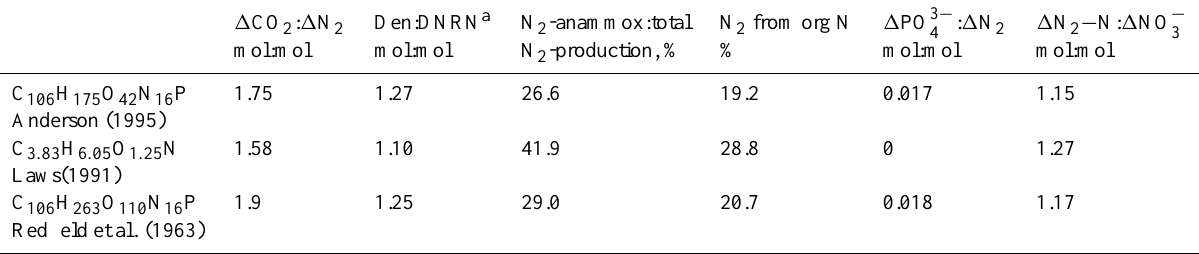
Table 2. Bulk ratios for complete conversion of fixed nitrogen to N 2 (i.e. no accumulation of NO − organic matter. Bulk 1 CO 2 : 1 N 2 ratios include the effect of autotrophic CO 2 fixation (data for scenario I, with DNRN, denitrification and anammox,